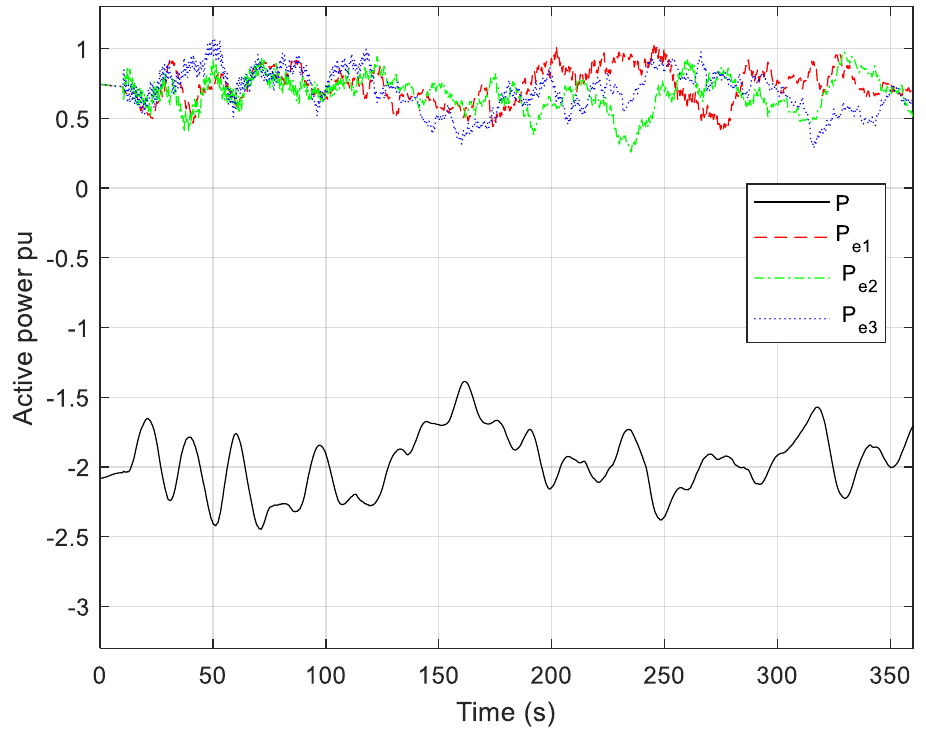
Figure 25. Active power of the B2B converter and active power of the PMSGs (random wind disturbance).